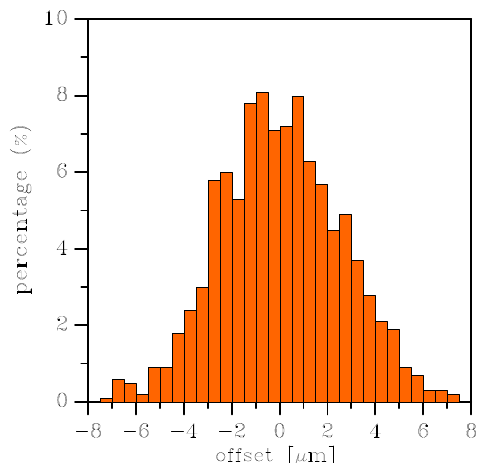
Figure 11. Histogram of the offset from the rest position for the 200 × 2 µ m 2 case (uniform strain BCs).